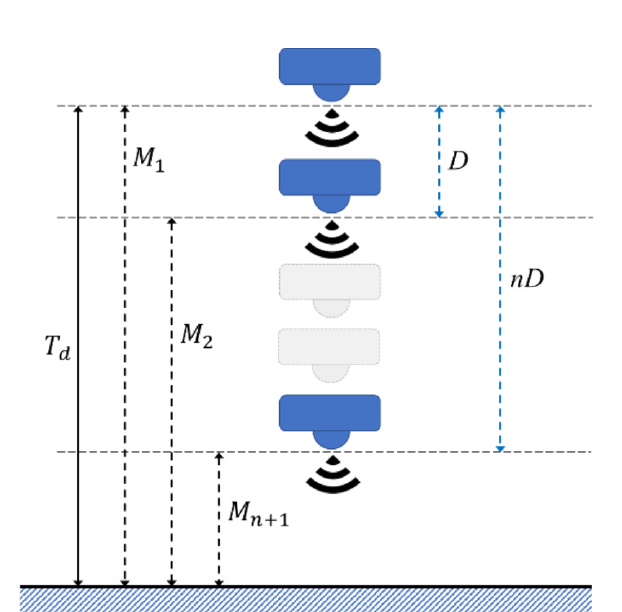
Figure 2. Distance naming rule in multi-step